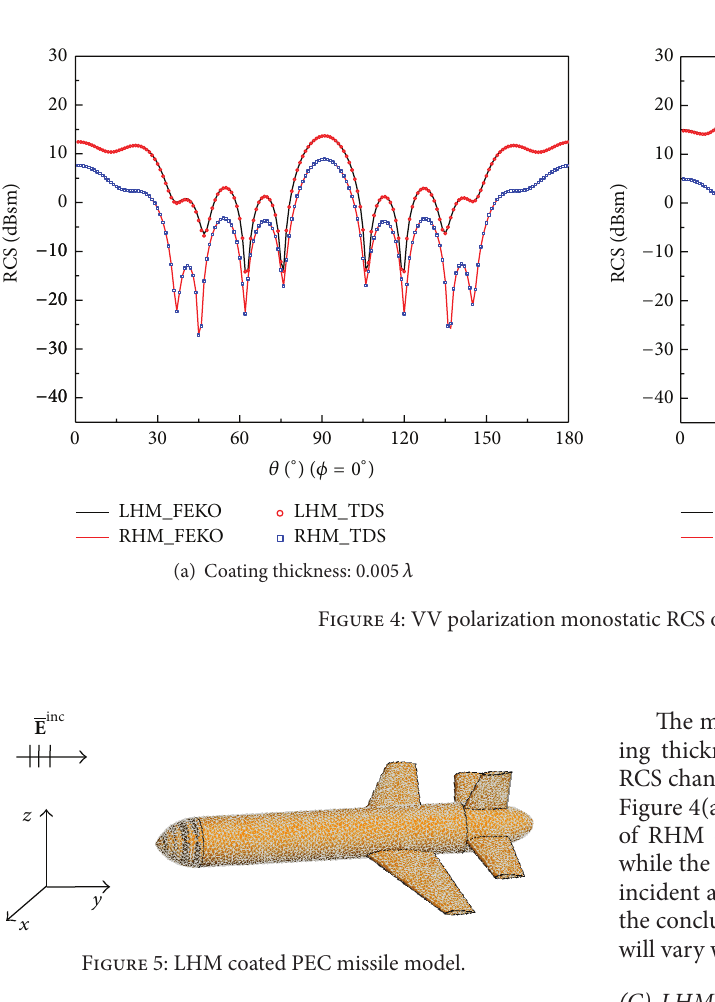
Figure 3: LHM coated PEC cylinder.